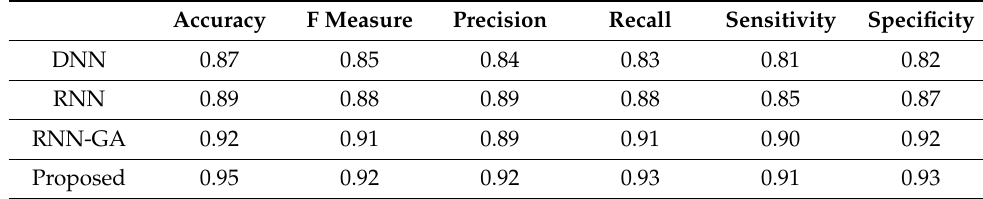
Table 3. Performance metrics comparison. Figure 10. Precision performance of confusion matrix.